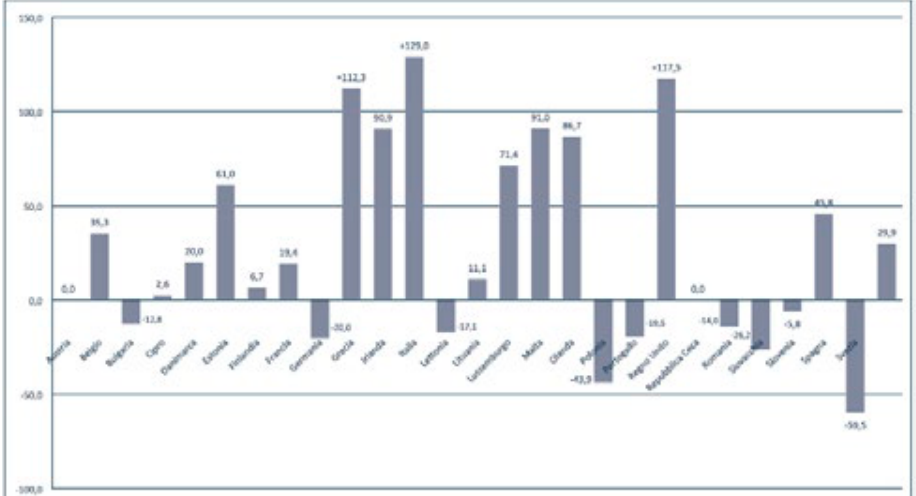
Figure 1. Inability to afford a protein meal every two days in EU countries, comparison 2007-2013 (percentage